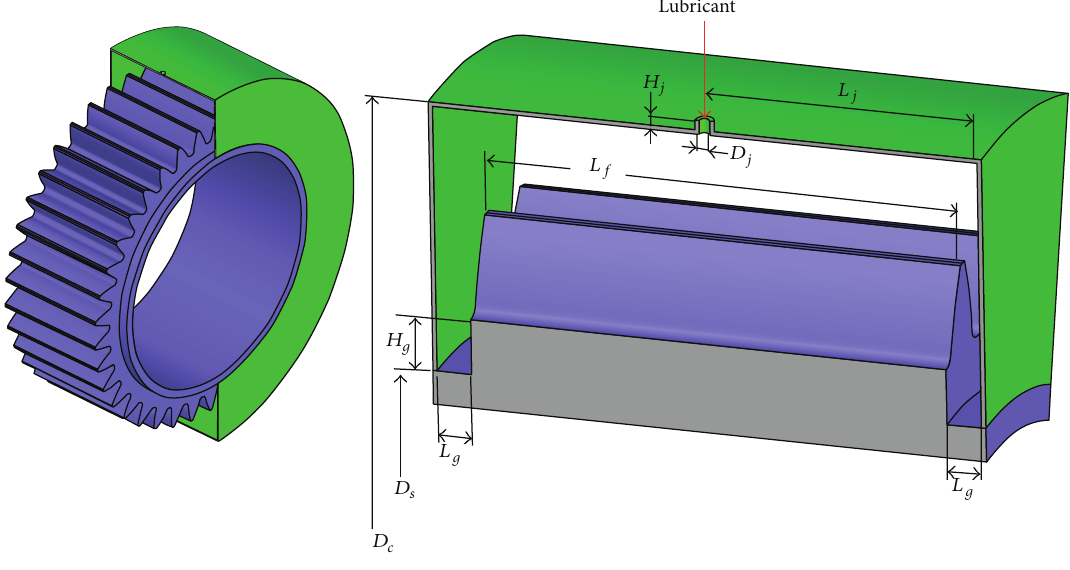
Figure 1: Sketch of reference geometry.